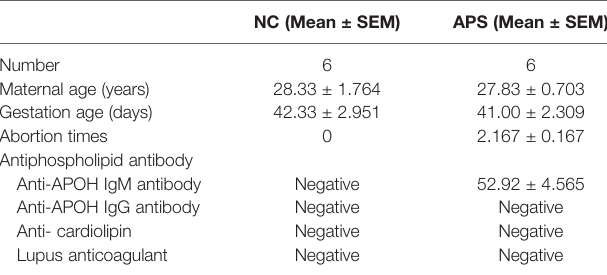
TABLE 1 | The clinical features of healthy early pregnancy patients and early pregnancy patients with antiphospholipid syndrome (APS). NC (Mean ±